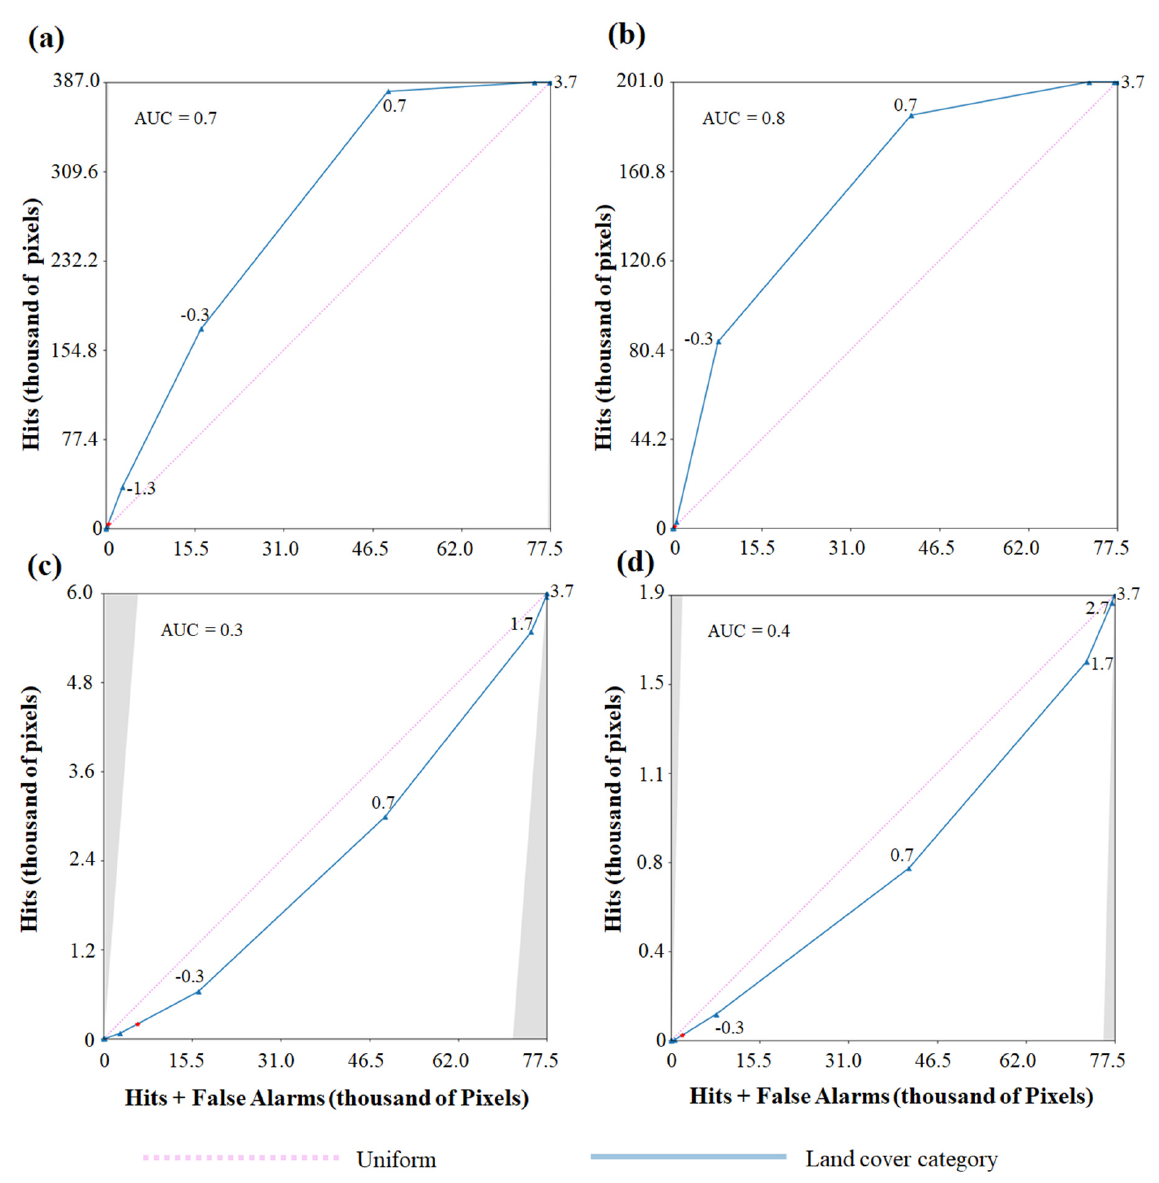
Figure 9. TOC curves for the gains of ( a , b ) water during the first and second time intervals and ( c , d ) bare land during the first and second time intervals.